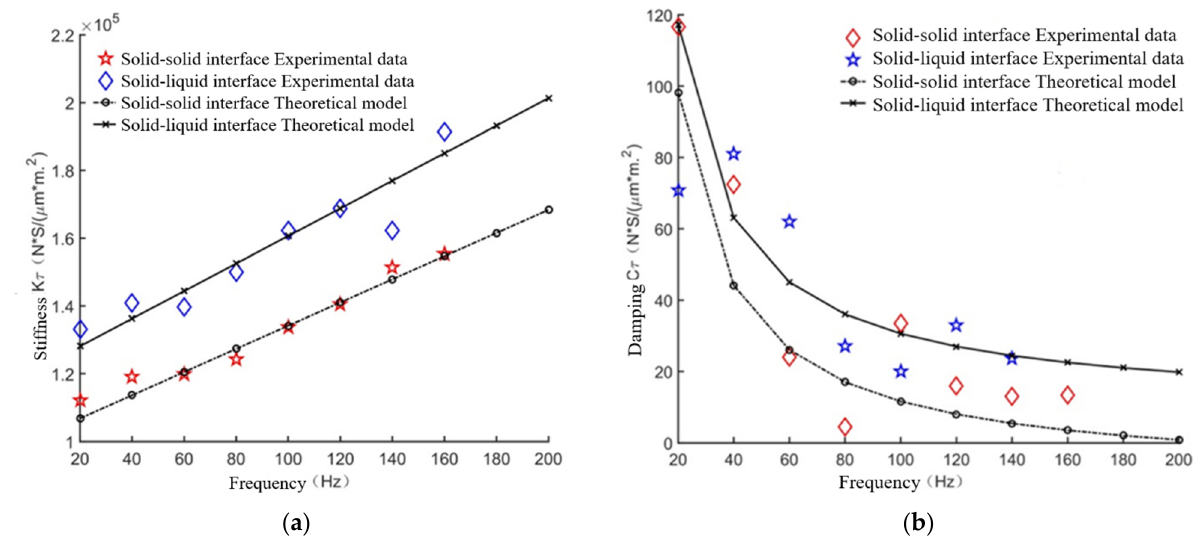
Figure 13. Comparison and verification of the theoretical model and the experimental data of dynamic characteristic parameters varying with frequency. ( a ) Tangential contact stiffness, ( b ) tangential contact damping.